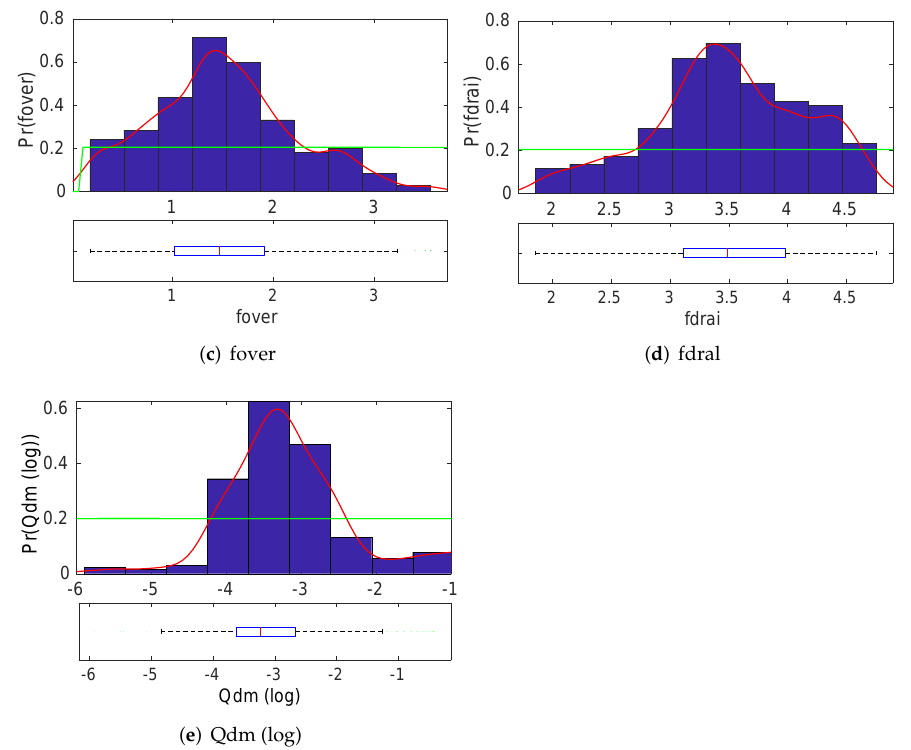
Figure 5. A posteriori distributions of the input parameters of CLM4 for a given output u f . The red line indicates the posterior density, whereas the green line indicates the prior density of the parameter. (BMA evaluation).